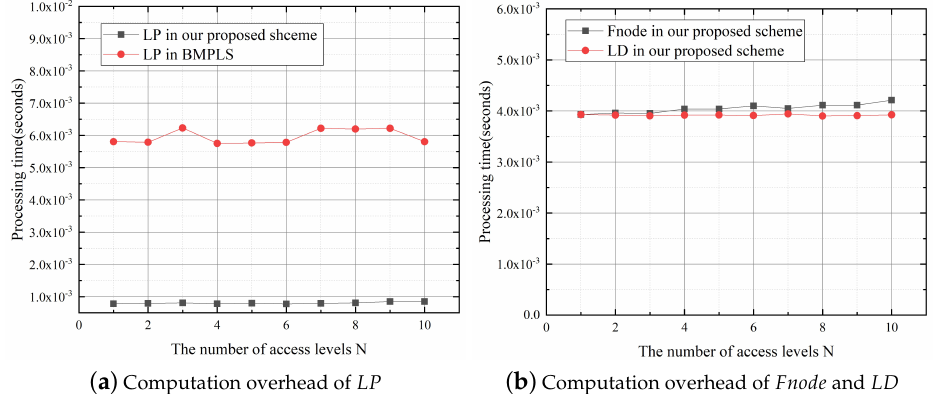
Figure 9. Computation overhead in the location record phase.